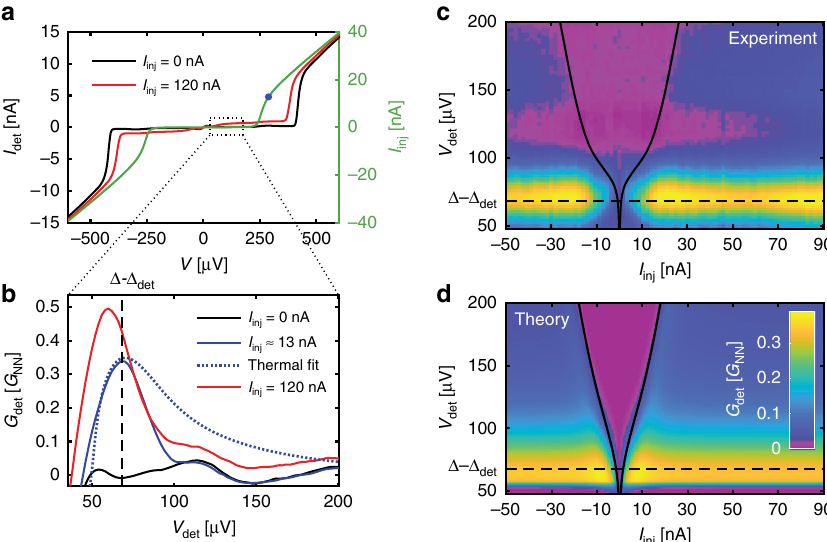
Fig. 3 Non-Fermi – Dirac quasiparticle distribution. The magnetic fi eld ( H ) is zero for all panels in this fi gure. a Current ( I det ) as a function of voltage ( V det ) across the closest SIS' detector junction (J det1 ) for injection currents I inj = 0 nA (black) and I inj = 120 nA (red). On the right vertical scale, I inj as a function of voltage V inj across the NIS injector junction J inj (green). b Differential conductance ( G ), in units of the normal state value, as a function of ( V ) across det det J det1 for I inj = 0 nA (black), I inj ≈ 13 nA (blue, blue dot in a ), and I inj = 120 nA (red). The vertical dashed line indicates eV det ¼ Δ (cid:2) Δ det : G det at this voltage is proportional to the number of quasiparticles in the superconducting wire at E = Δ . An attempted fi t with an effective temperature T * ≈ 1.1 K in S reproduces the peak at I inj = 13 nA, but grossly overestimates the QP population at higher energies (dashed blue line). In this fi t, we use the experimentally determined values Δ = 245 μ eV and Δ det ¼ 180 μ eV, T det ¼ 90 mK and a phenomenological depairing α ≈ 0.01 Δ . c G det at J det1 as a function of V det and I inj with the slice at I inj = 0 subtracted from all data. The black lines show the measurement of ± I inj ( V inj ) from a shifted downwards by Δ det = e . The black lines fall at the location of a step-like feature in the colour map, as expected: as shown in Fig. 1b, QPs in S are created up E ≈ eV inj + k B T , leading to a step-like cutoff in the distribution function. The dashed line again indicates eV det ¼ Δ (cid:2) Δ det , where the QP density is maximal due to the coherence peak in the DOS of S. d Theoretical prediction of c , with Δ , Δ det and α as in b .